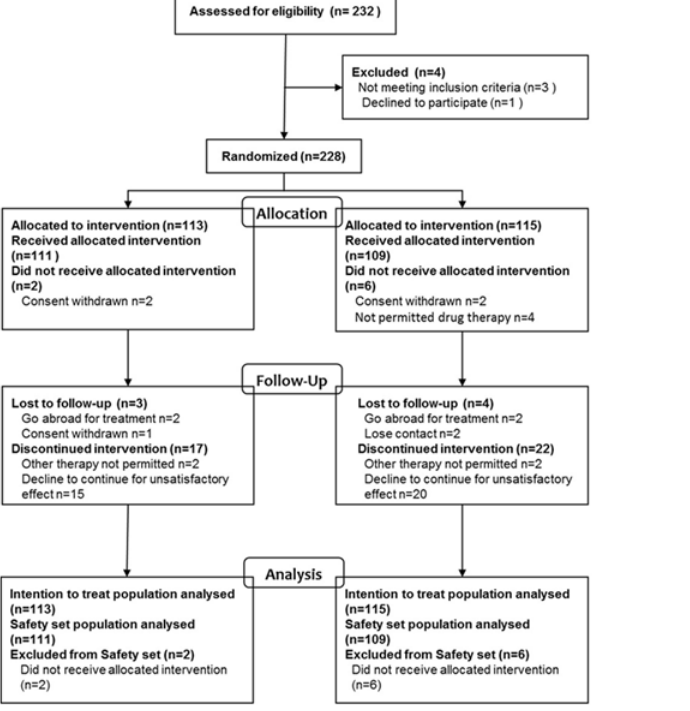
Figure 1. CONSORT